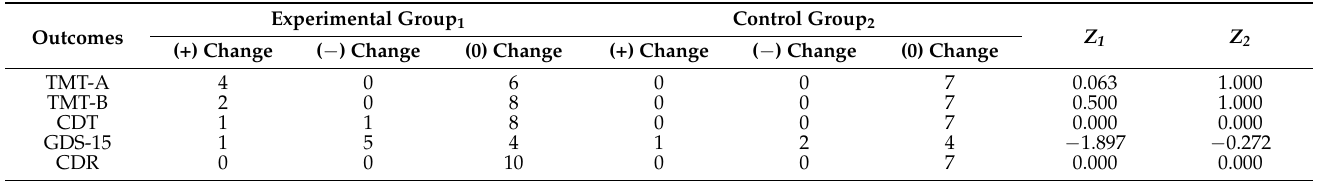
Table 4. Pre-post comparisons for the nonparametric